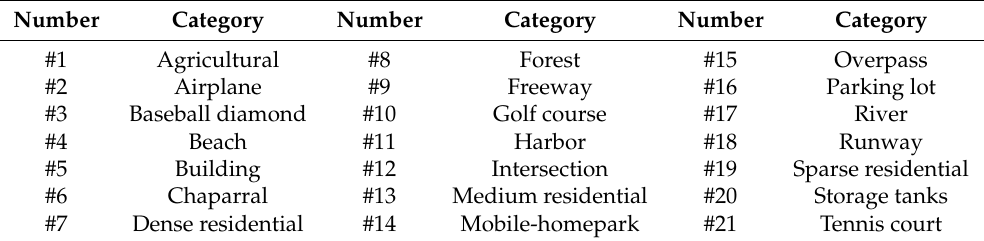
Table 2. The number of features and categories on the UCM dataset.